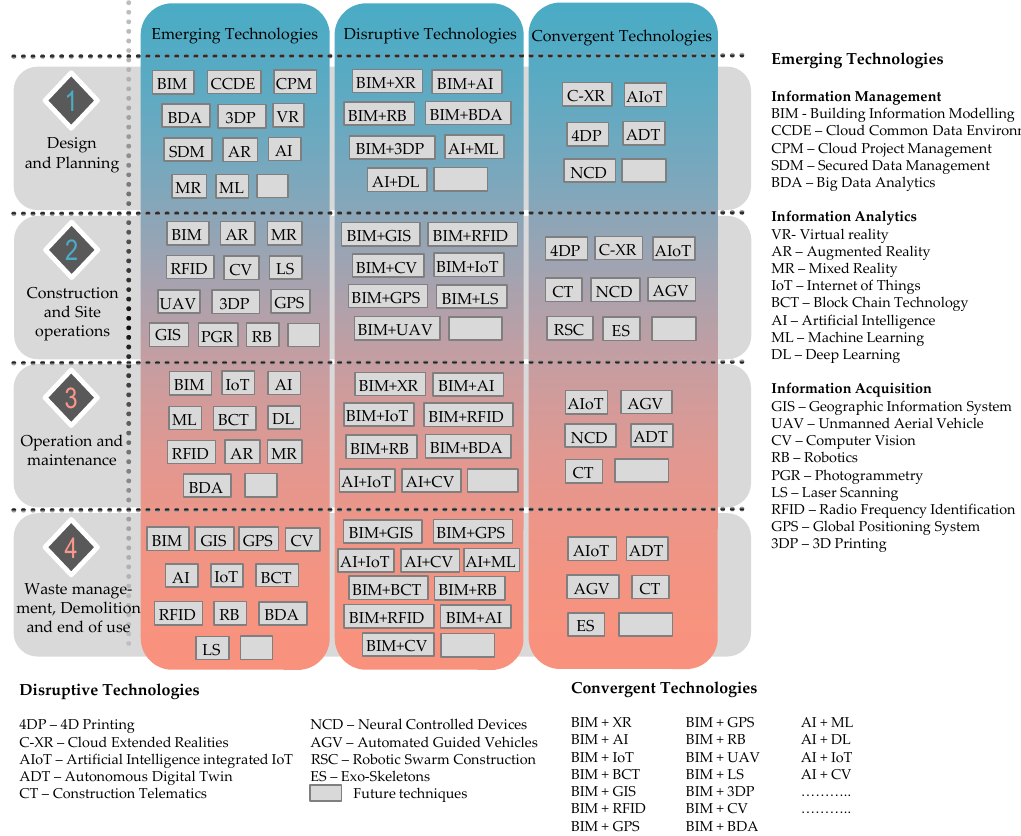
Figure 12. Mapping the technologies to their relevant stage of work.